Question: Express in one sentence what the figure is showing.
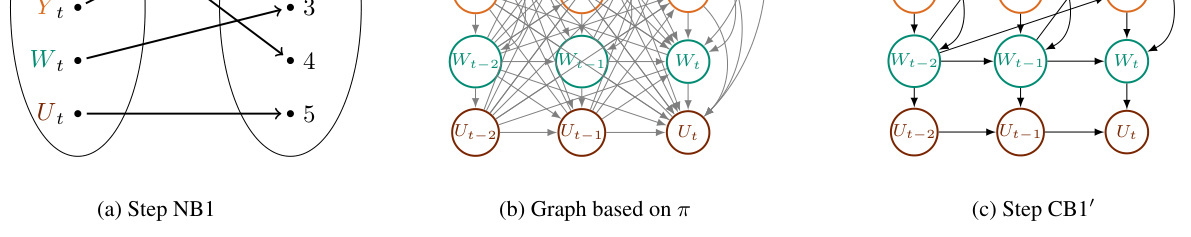
Answer: Illustration of the NBCB algorithm for the running example. (a) Output of the NB1 step (b) Output of the CB1′.